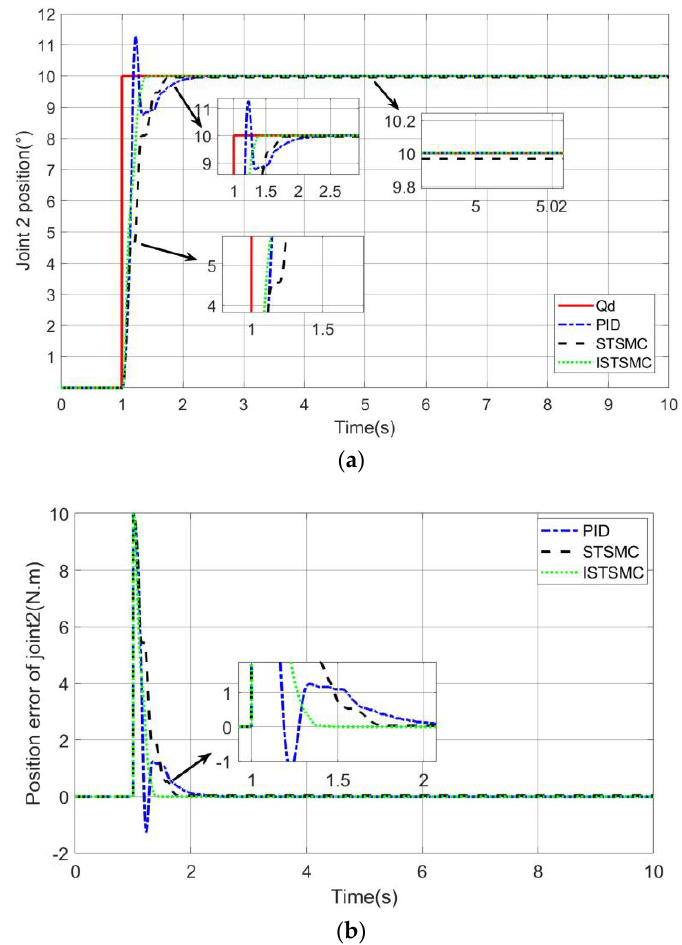
Figure 4. Joint 2 is suddenly disturbed at 5.9 s. ( a ) Trajectory tracking diagram; ( b ) trajectory tracking error diagram.